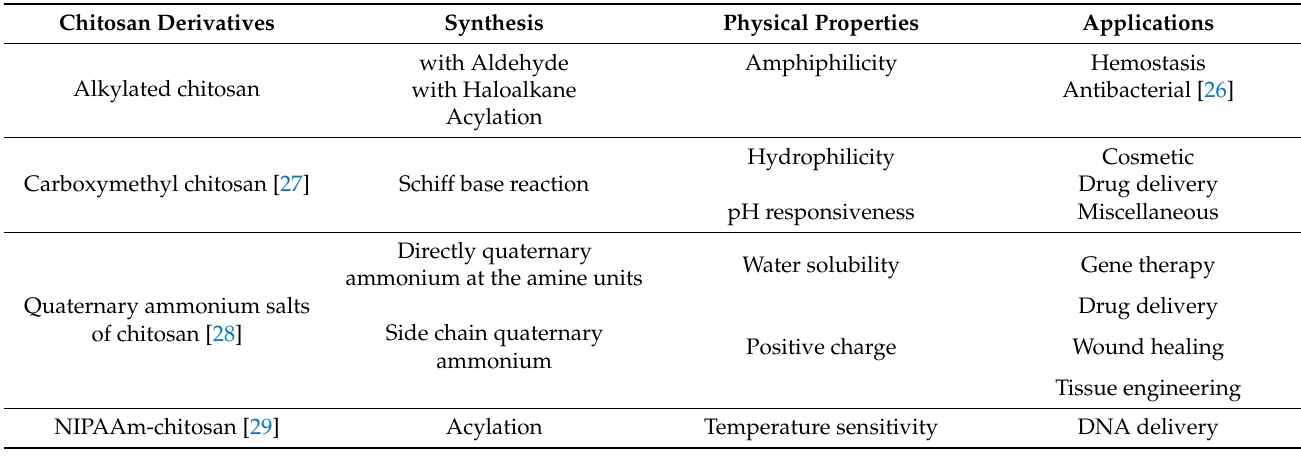
Table 1. Different kinds of chitosan derivatives and their synthetic methods, physical properties and